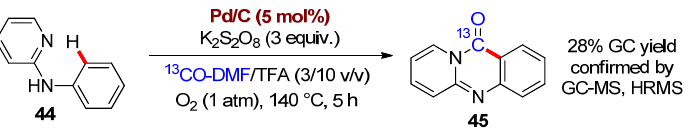
Scheme 17. Pd/C-catalyzed carbonylative cyclization of N -phenyl pyridin-2-amine 44 using